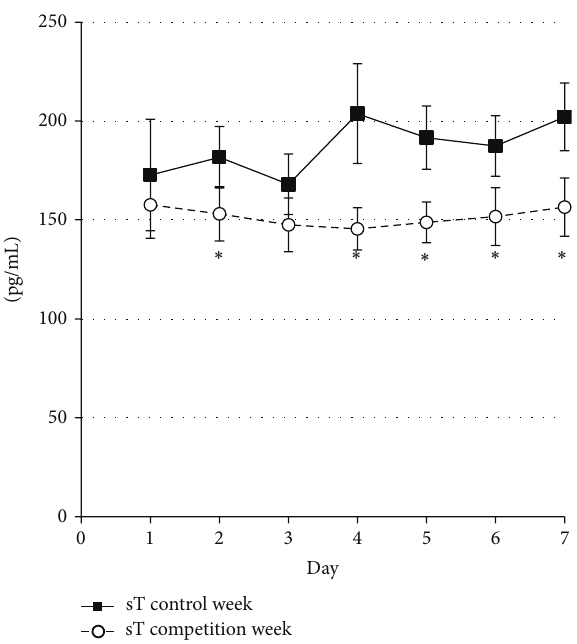
Figure 2: Salivary testosterone (sT) levels during the control and competition week. ∗ Significant differences between control and experimental week (𝑃 < 0.05) . Values are mean ± SE.